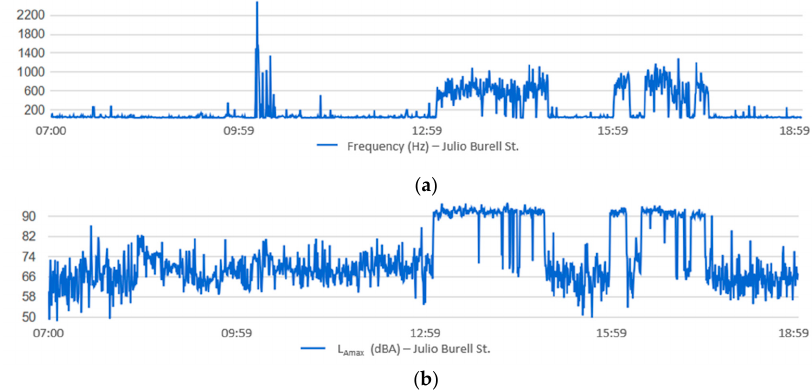
Figure A5. ( a ) The predominant frequency measured by the sensor node located at Julio Burell St. during 22 November 2016, in a daytime period. ( b ) Maximum noise measured in Julio Burell St. location for the daytime period on 22 November 2016.